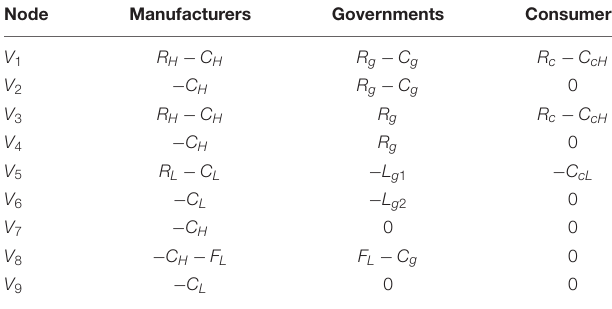
TABLE 3 | Payoffs of governments, manufacturers, and